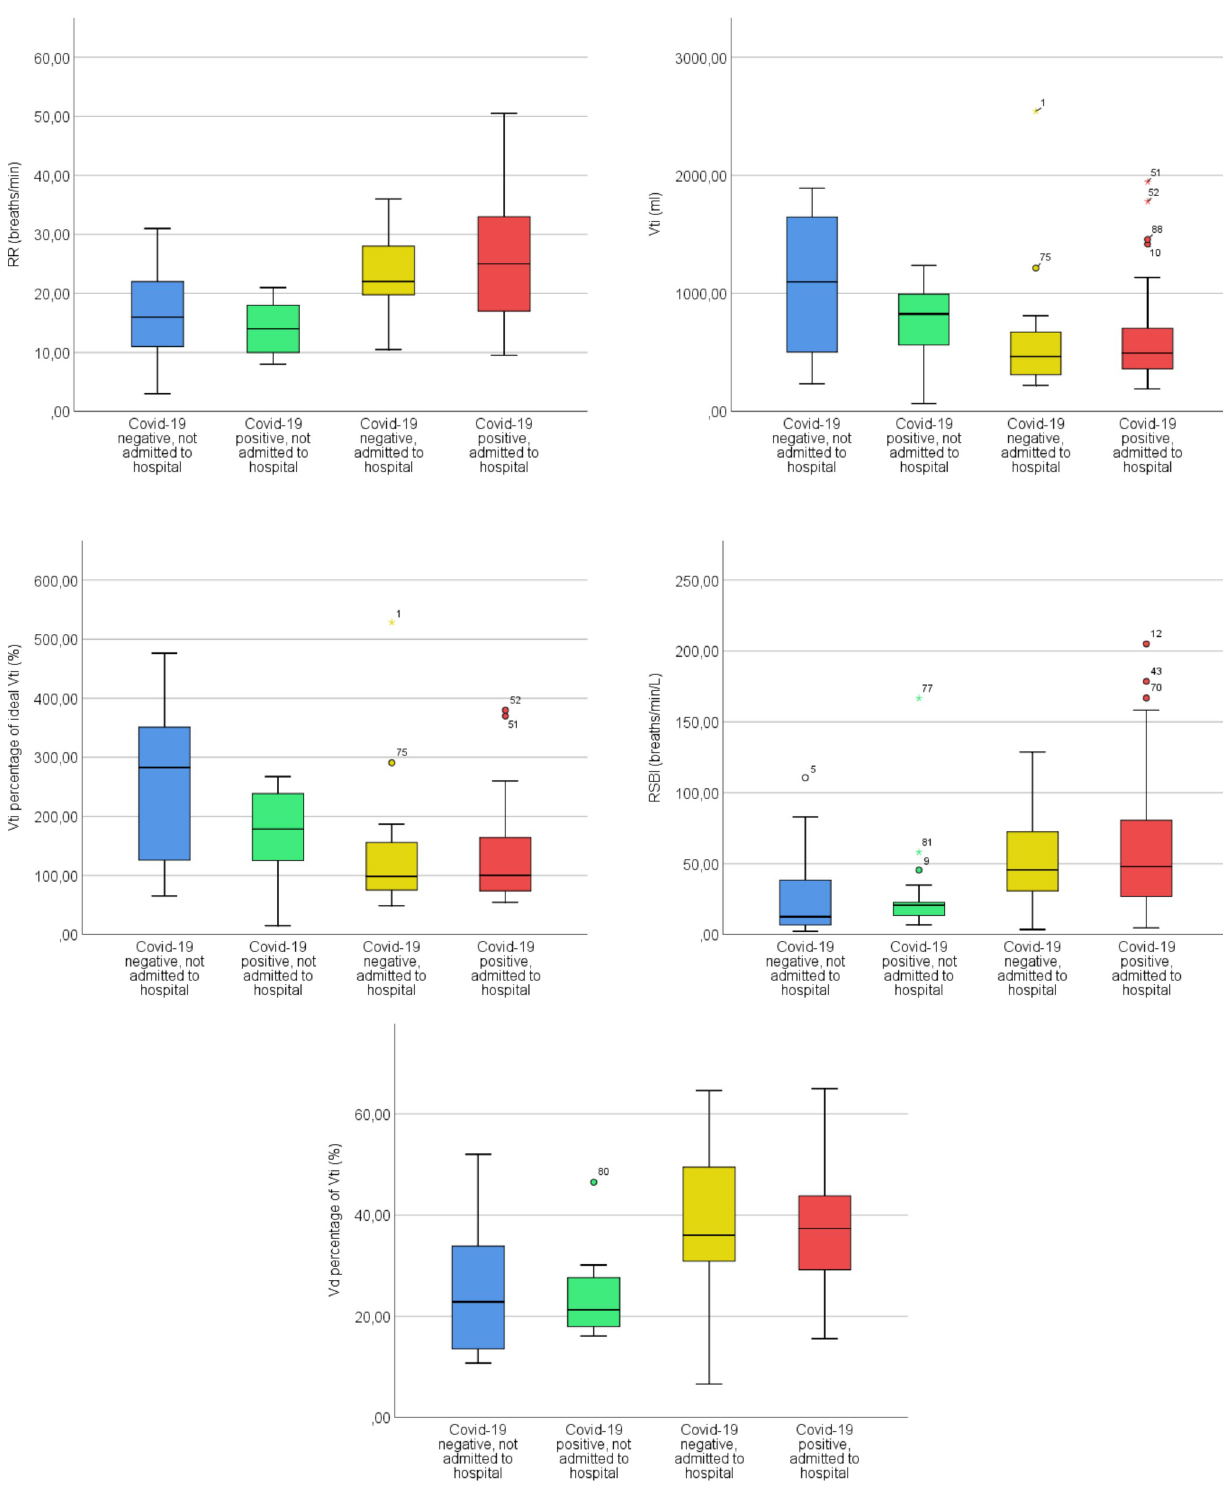
Fig 2. Boxplots of significant differences in physiological respiratory parameters, hospital admissions and COVID-19.